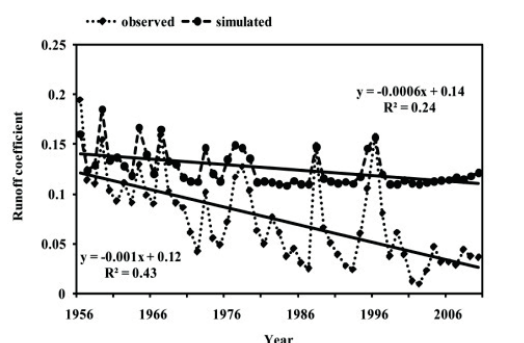
Fig. 4 The variation of runoff coefficient during the period of 1956–2010.